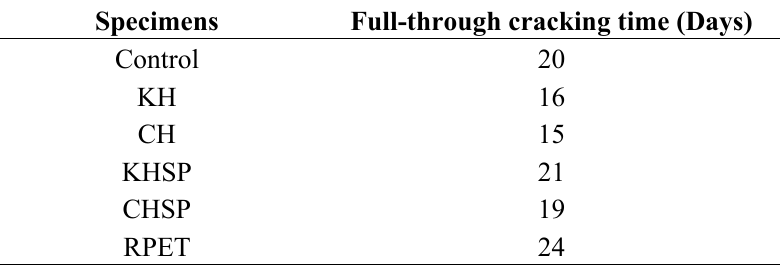
Table 3. Restrained drying shrinkage cracking test results.